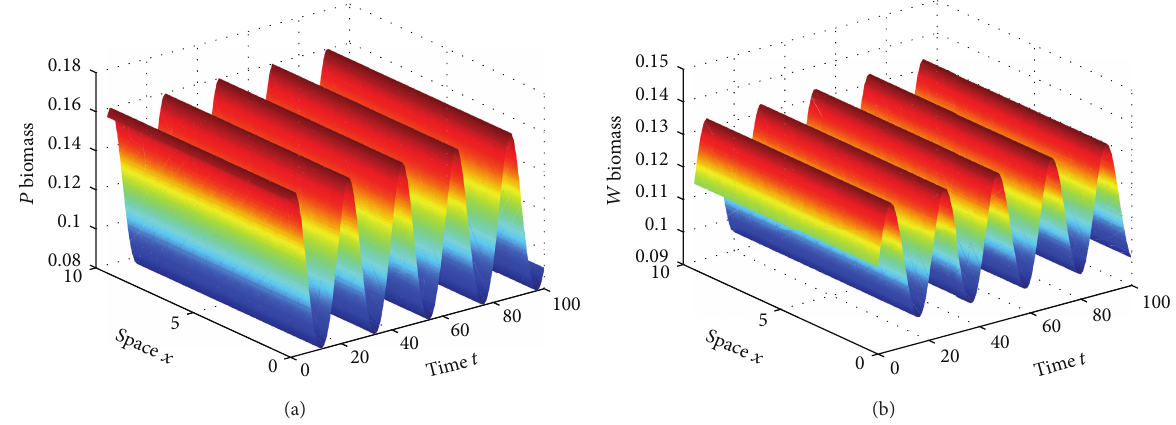
Figure 2: Illustration of the existence of spatially homogeneous periodic solutions of system (2) for 𝑠 = 0 . 15, 𝑏 = 0 . 15373, 𝑎 = 10, 𝑘 = 0 . 2, = 3, and 𝑑 = 1 and initial conditions (𝑃 𝑑 1 2